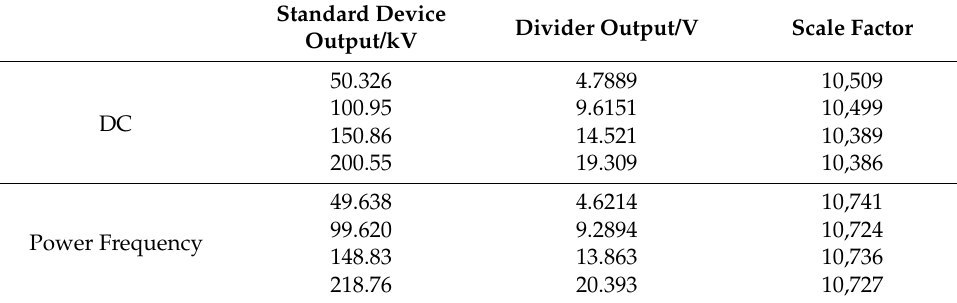
Table 5. Test results at − 20 ◦